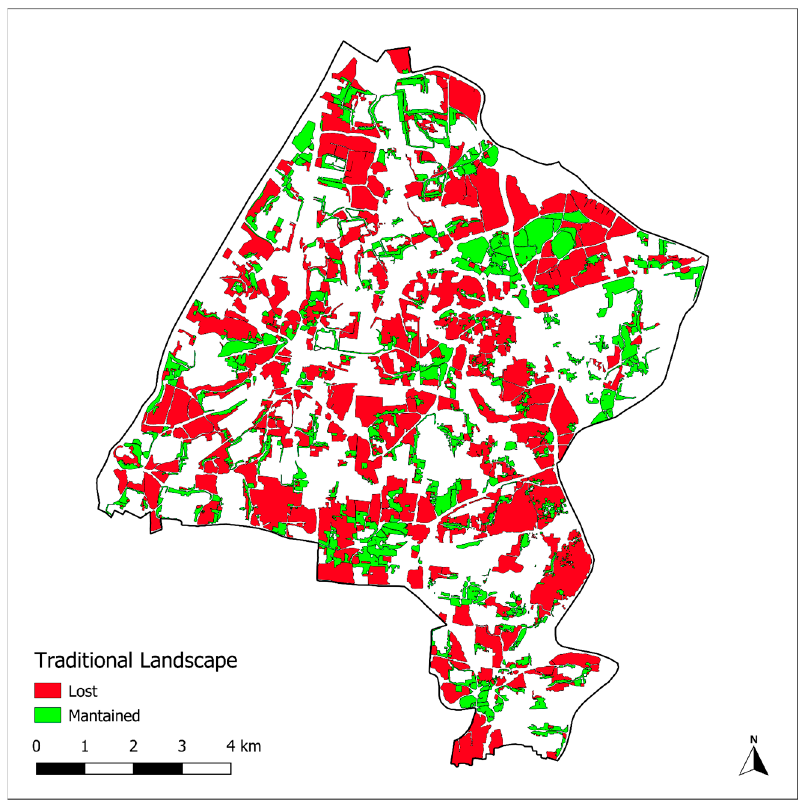
Figure 7. Map of the evolution of traditional land uses in the period 2009–2021.